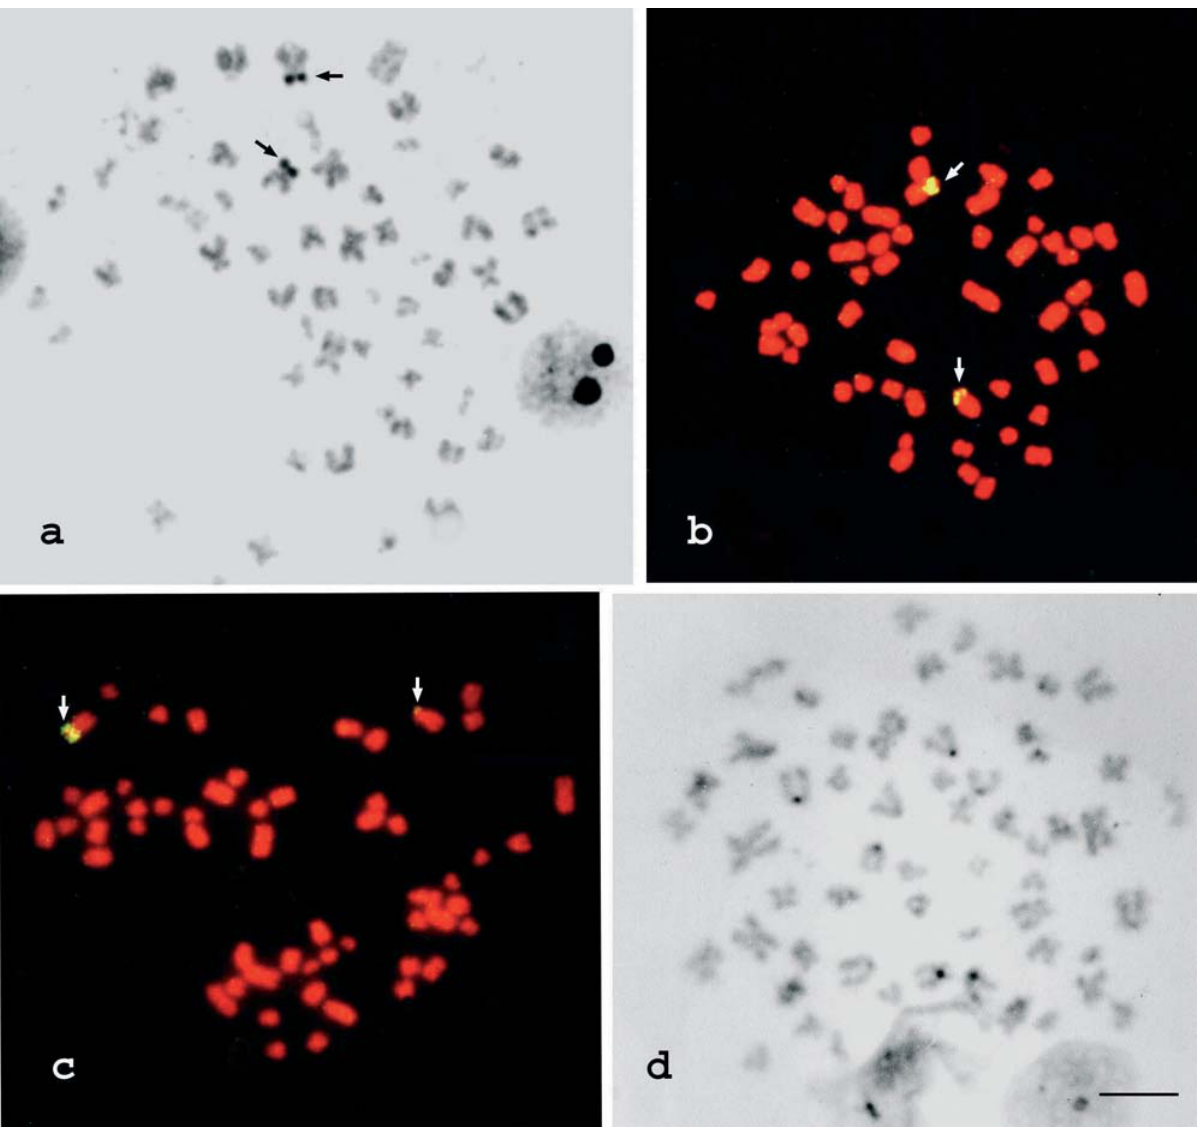
Fig. 2. Metaphases of Arapaima gigas. (a) Silver nitrate-stained showing two Ag-NOR sites (arrows); (b) and (c) 18S rDNA - FISH showing a single NOR-bearing chromosome pair and NOR size polymorphism (arrows); (d) C-banded chromosomes showing centromeric heterochromatin. Bar = 5